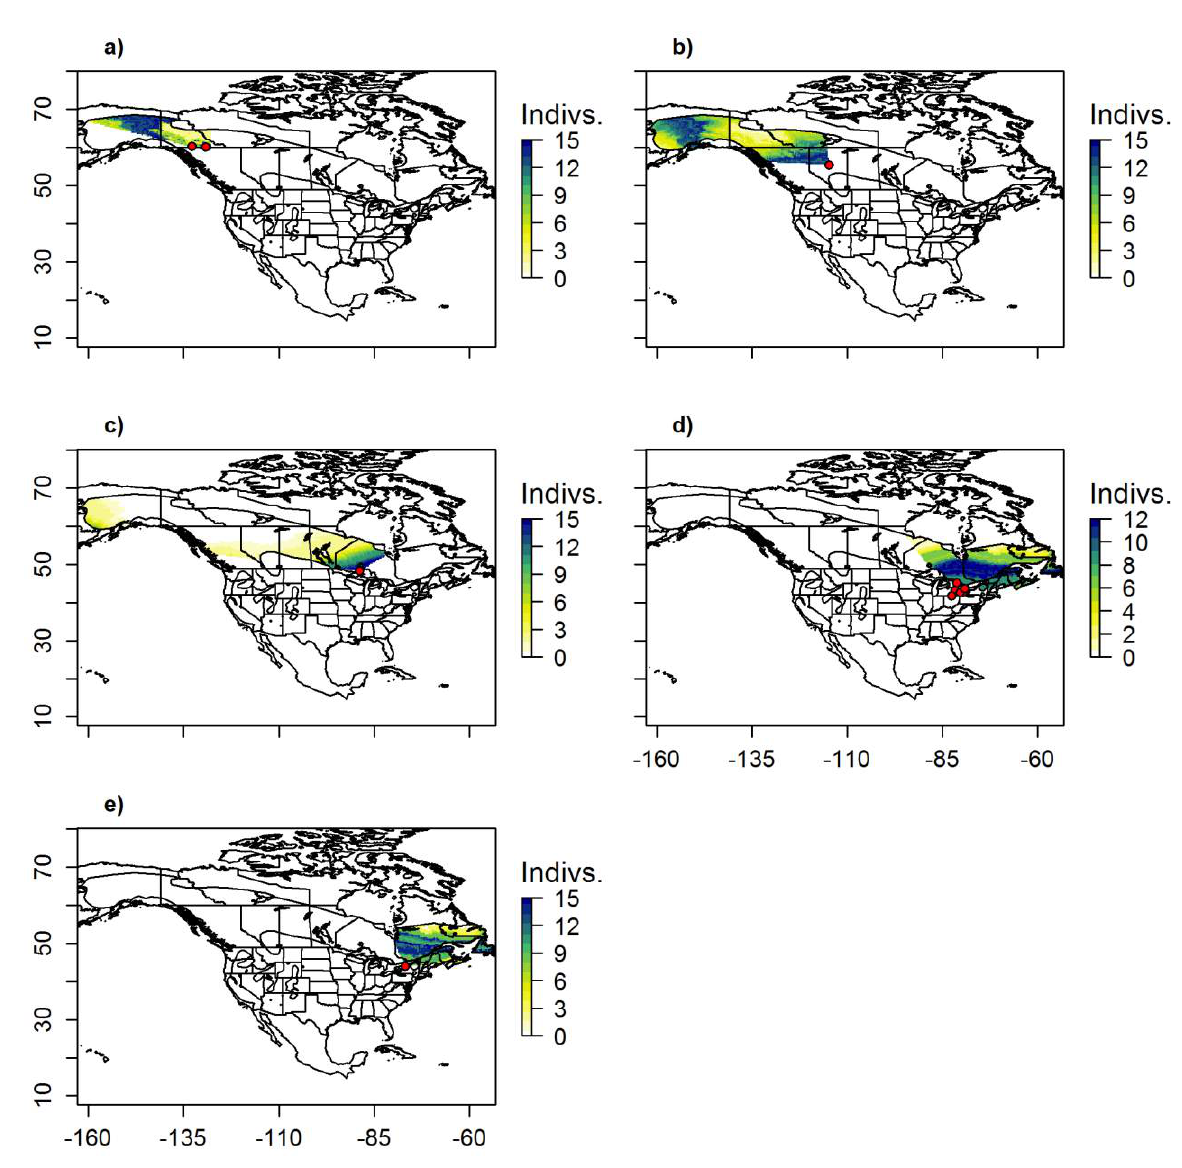
Figure A2.2: Probable origins of second year (SY) of Swainson’s Thrush es ( Catharus ustulatus ) captured during spring migration at CMMN stations in a) the Yukon (ACBO (n=16), TLBBS (n=9)); b) Northern Alberta (LSLBO (n=25)); c) Western Ontario (TCBO (n=20)); d) Southwest Ontario (AuBO (n=3), BPBO (n=2), HBO (n=3), LPBO (n=3), PIBO (n=3), TTPBRS (n=3)); and e) Southeast Ontario & Southwest Québec (PEPTBO